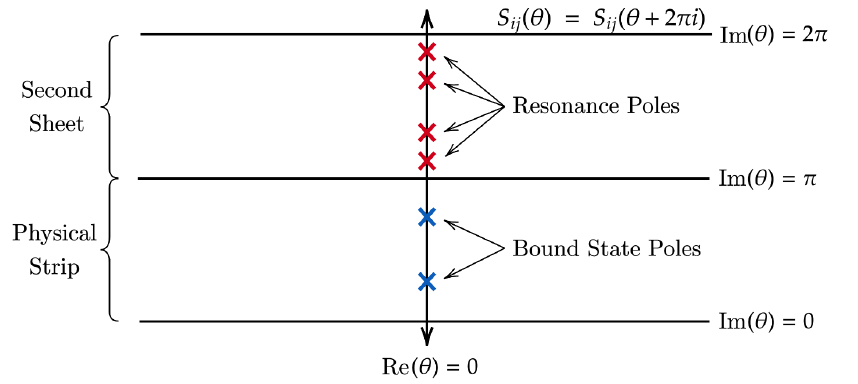
Figure 1 . Analytic structure of the 2 → 2 rapidity-space S -matrix for purely elastic theories. S ( θ ) is periodic with period 2 πi , bound state poles appear on the physical strip 0 ≤ Im ( θ ) ≤ π while resonance poles appear on the second sheet π ≤ Im ( θ ) ≤ 2 π